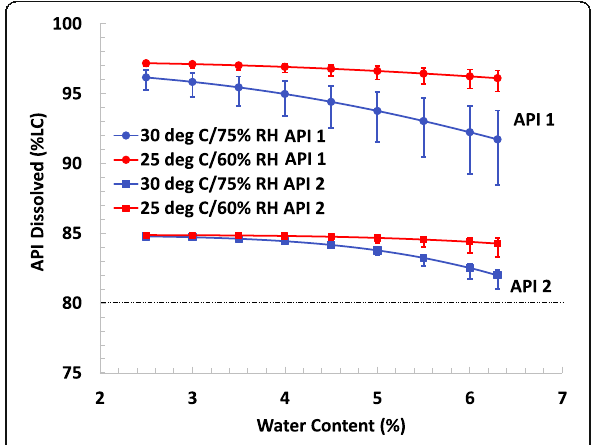
Fig. 5 Relationship between the Predicted Percent Dissolved at 20 min of Both Active Pharmaceutical Ingredients after Two Years and the Initial Water Content at 25 °C/60%RH and 30